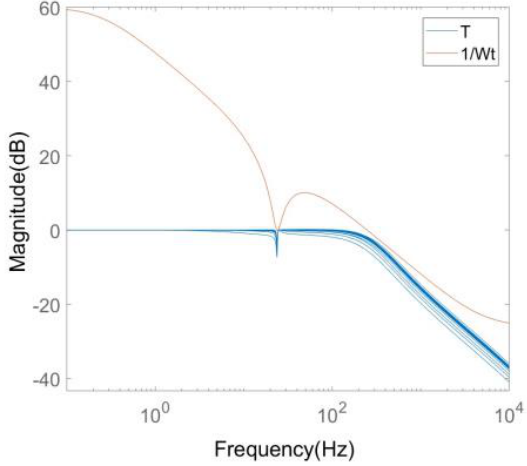
Figure 21. Sensitivity curves.